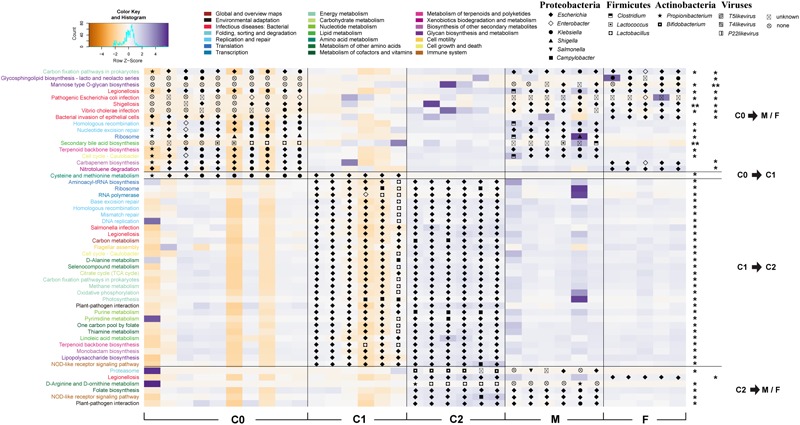
Significant gut microbial pathways of giant pandas with age. The heatmap profile shows scaled abundance (by row z-score) of significantly changed pathways in the gut of giant panda by age. Hosts of the pathways are marked on abundance patches. Pathways are colored according to KEGG pathway classifications, as in the figure legend. The significance of these pathways was evaluated by Wilcoxon test (p-values were adjusted by Holm method. ∗0.01 < p < 0.05; ∗∗p < 0.01).